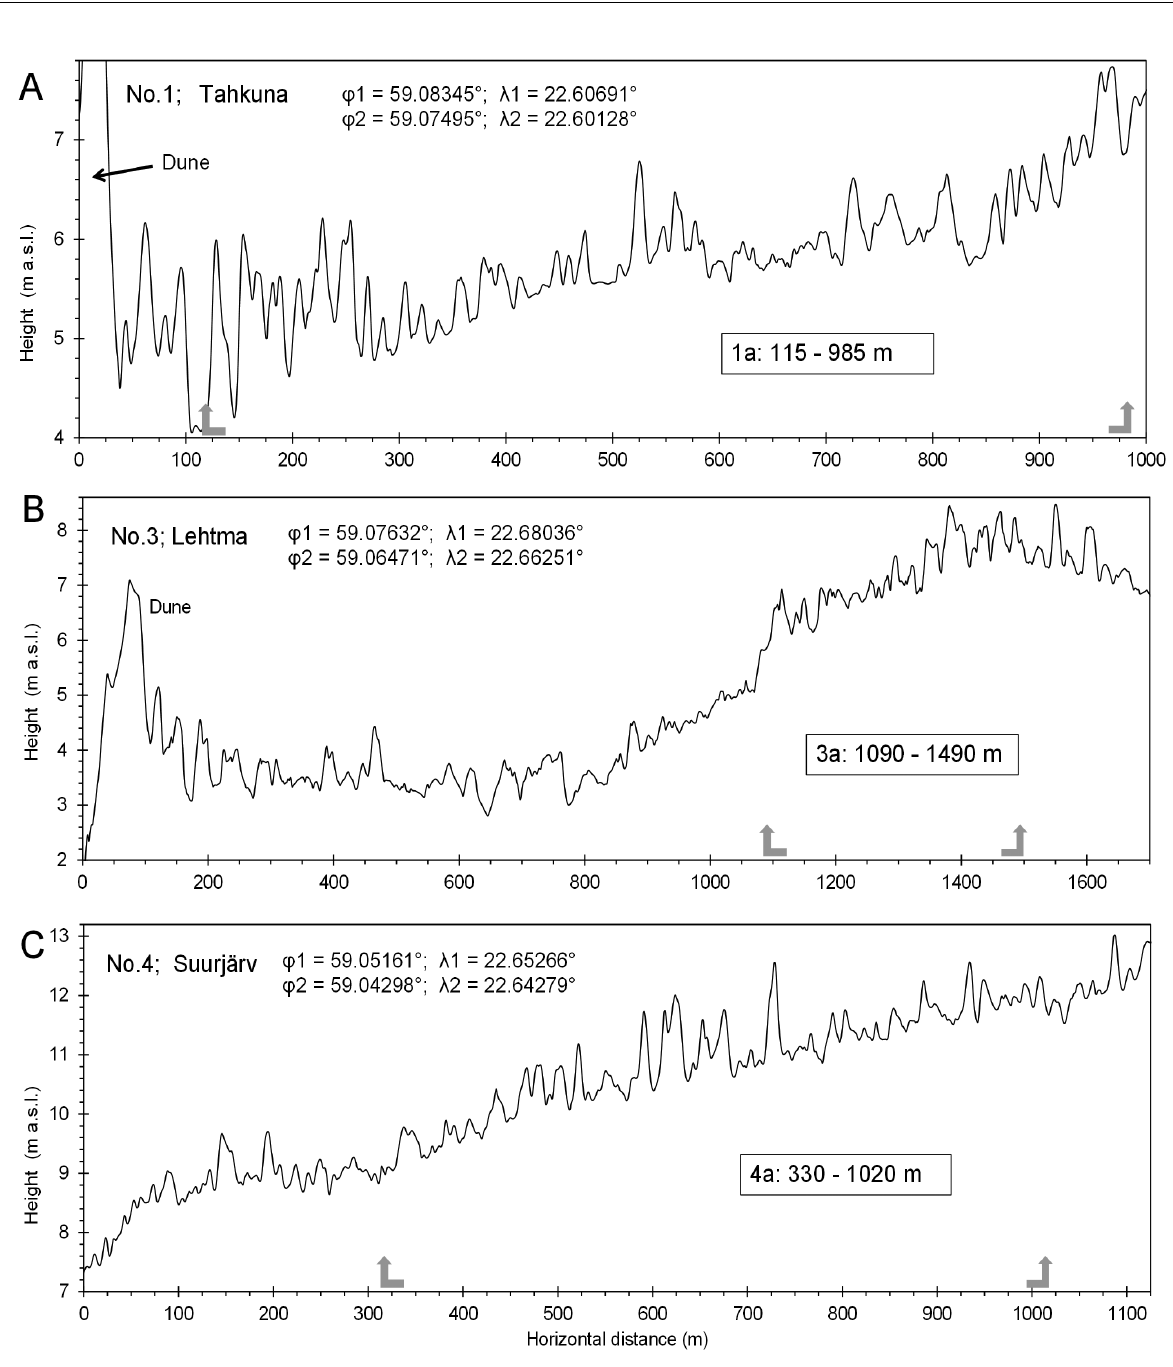
Fig. 5. Excerpts of height profiles (see also Tables 1, 2 and Figs 1, 4). Geographical latitudes ( φ , N) and longitudes ( λ , E) are given for initial ( φ 1, λ 1) and terminal ( φ 2, λ 2) points of the excerpted selections. The length spans used in the statistics (Table 2) are indicated with arrows and in the text boxes. ( Continued on the next page